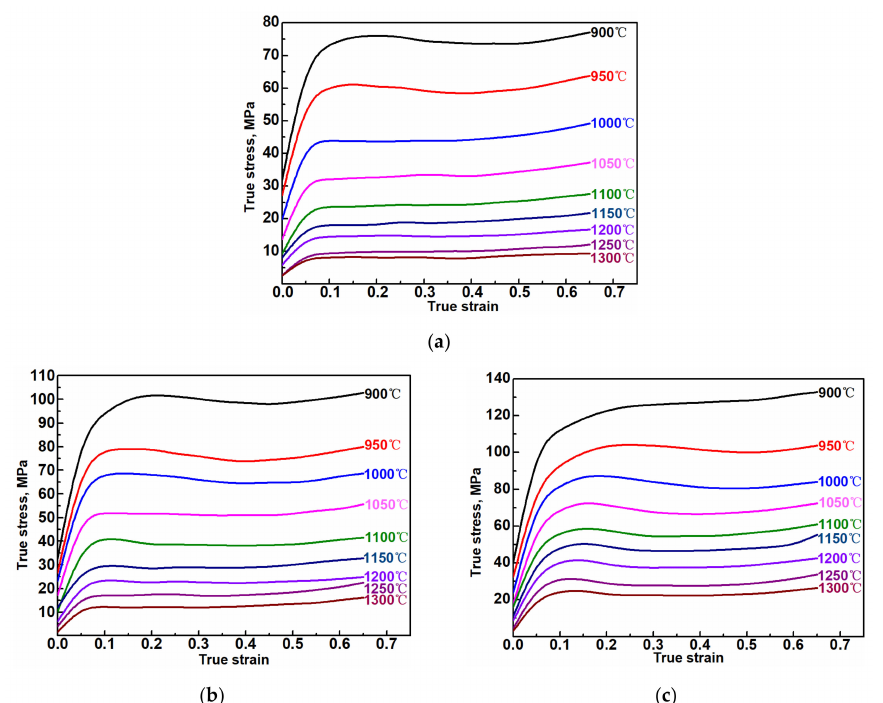
Figure 5. The measured true stress-strain at different temperature and strain rate of ( a ) 0.001 s − 1 , ( b ) 0.01 s − 1 , and ( c ) 0.1 s − 1